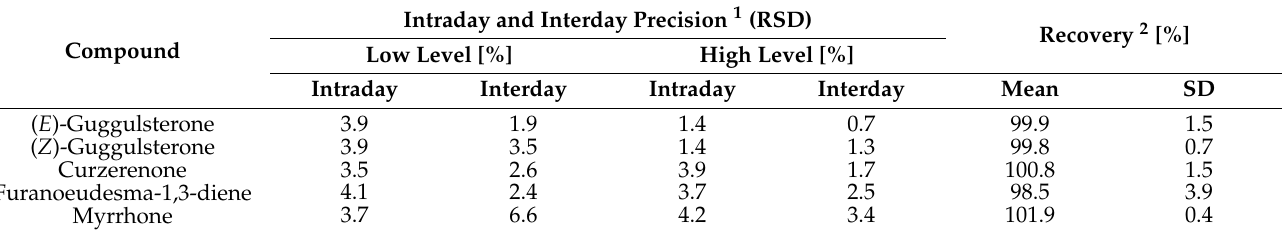
Table 2. HPLC-MS/MS validation data: Precision and